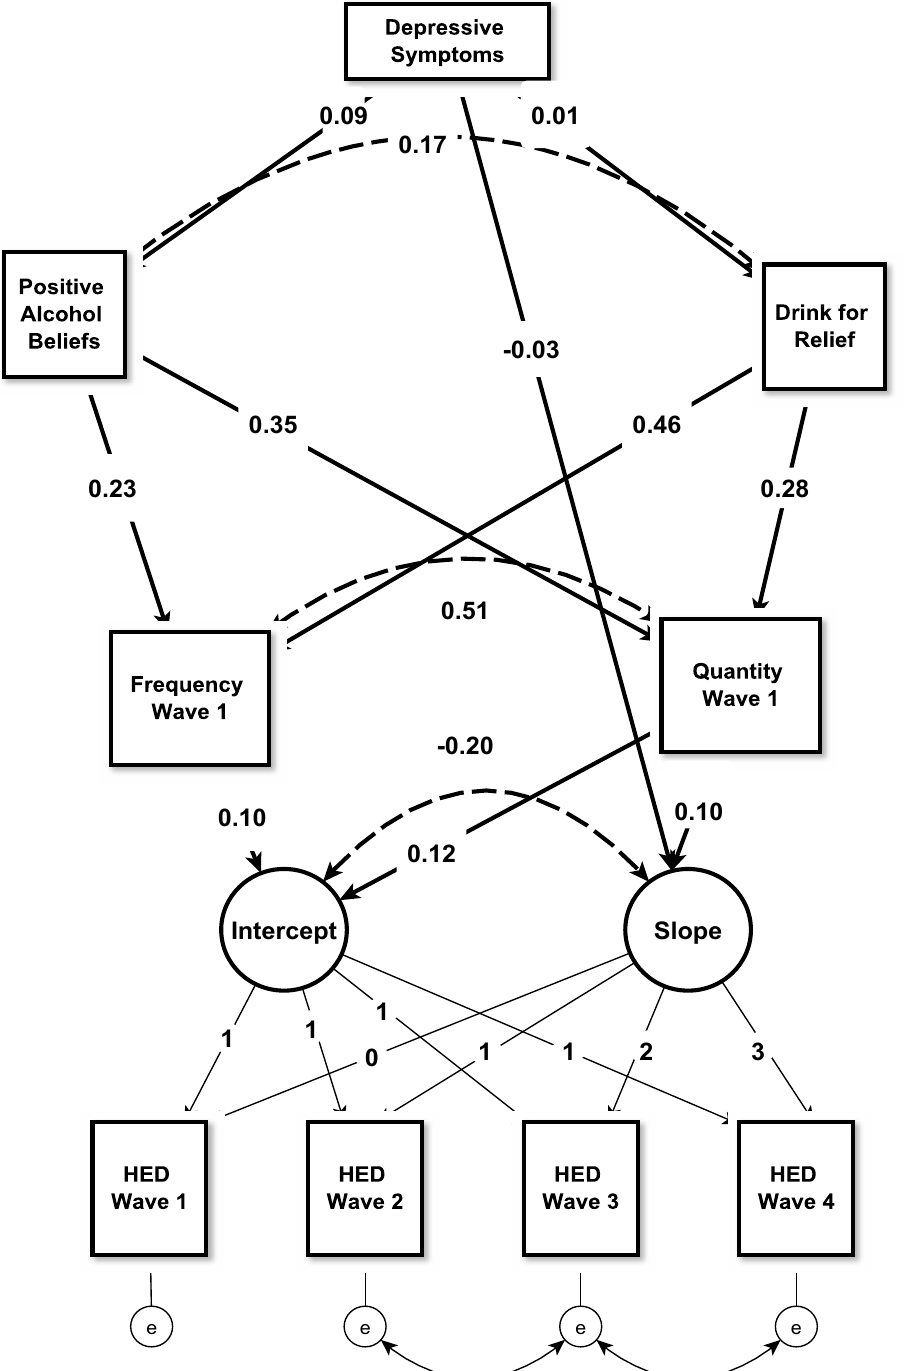
Figure 1. Parallel process linear growth model of the relationship between depressive symptoms and heavy episodic drinking (HED) over 2.5 years among adolescents who had engaged in HED never or only once at wave 1 ( n = 3021). Covariates (age, sex, socioeconomic status (SES), state, school type, sensation-seeking/rebelliousness, parental and friends’ drinking) were included in all equations. Solid lines represent regressions; dotted lines represent correlations. Table 5. Standardized regression coefficients (95% confidence intervals (CI) a ) from linear model of the association between depressive symptoms and heavy episodic drinking (HED) in adolescents who had engaged in HED ≤ 1 time at wave 1 ( n = 3021).